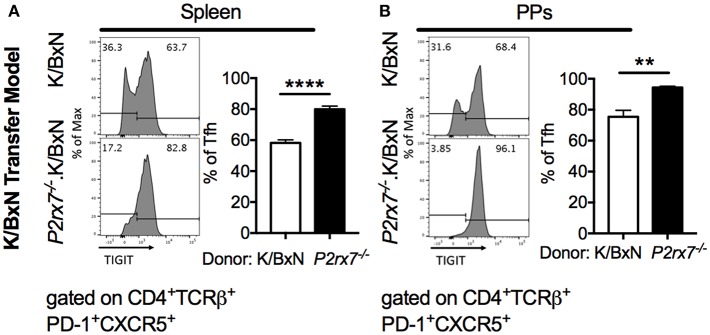
TIGIT is increased on P2rx7−/− Tfh cells in the SFB(–) K/BxN transfer model. (A,B) Representative histograms and compiled graphs of TIGIT expression on (A) splenic or (B) PP Tfh cells from WT or P2rx7−/−.K/BxN CD4+ cells transferred into TCRα−/−.BxN mice. Compiled graphs show TIGIT+ Tfh as a percentage of total Tfh cells. N = 7–9/group, 2 assays combined. **p < 0.01 ****p < 0.0001.